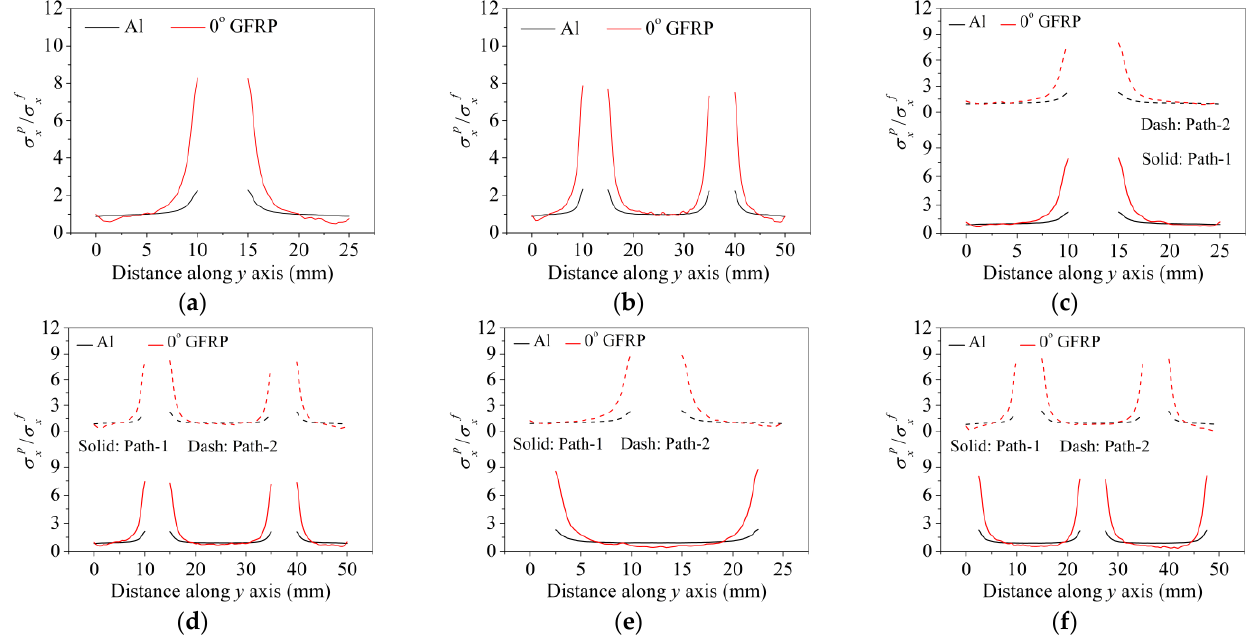
Figure 7. Axial stress distributions in off-axis Glare specimens: ( a ) H1R1; ( b ) H2R1; ( c ) H2R2P; ( d ) H4R2P; ( e ) H3R2S; ( f ) H5R2S.